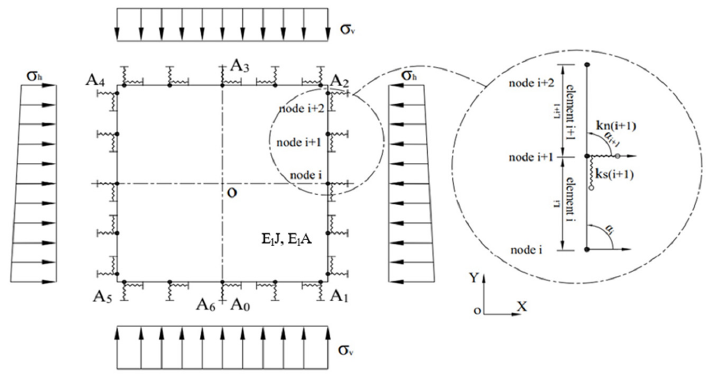
Figure 1. Diagram of the square tunnel in the HRM method.